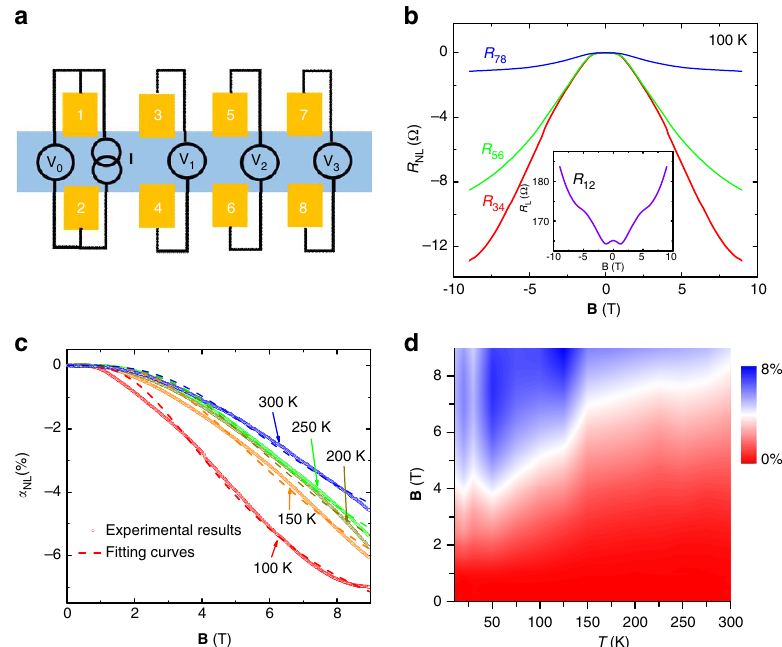
Figure 4 | Diffusion length dependence of valley transport. ( a ) Schematic view of the nonlocal resistance measurement in a Hall-bar-geometry device with one pair of local terminal (1–2) and evenly spaced three pairs of nonlocal terminals (3–4, 5–6, 7–8). The distance between terminal 3 and 4 (or 5 and 6, 7 and 8) is about 2 m m. The diffusion lengths of terminals 3–4, 5–6, and 7–8 are 2.5, 5.0 and 7.5 m m, respectively. ( b ) The extracted nonlocal resistance R NL ( R 34 , R 56 and R 78 ) of sample N1 measured in the Hall bar geometry at 100K. The inset is R L - B curves from terminal 1–2. ( c ) The nonlocal ratio a NL - B of sample N1 and the corresponding fitting curves at different temperatures. ( d ) A two-dimensional plot of a NL in sample N1 as a function of temperature and magnetic